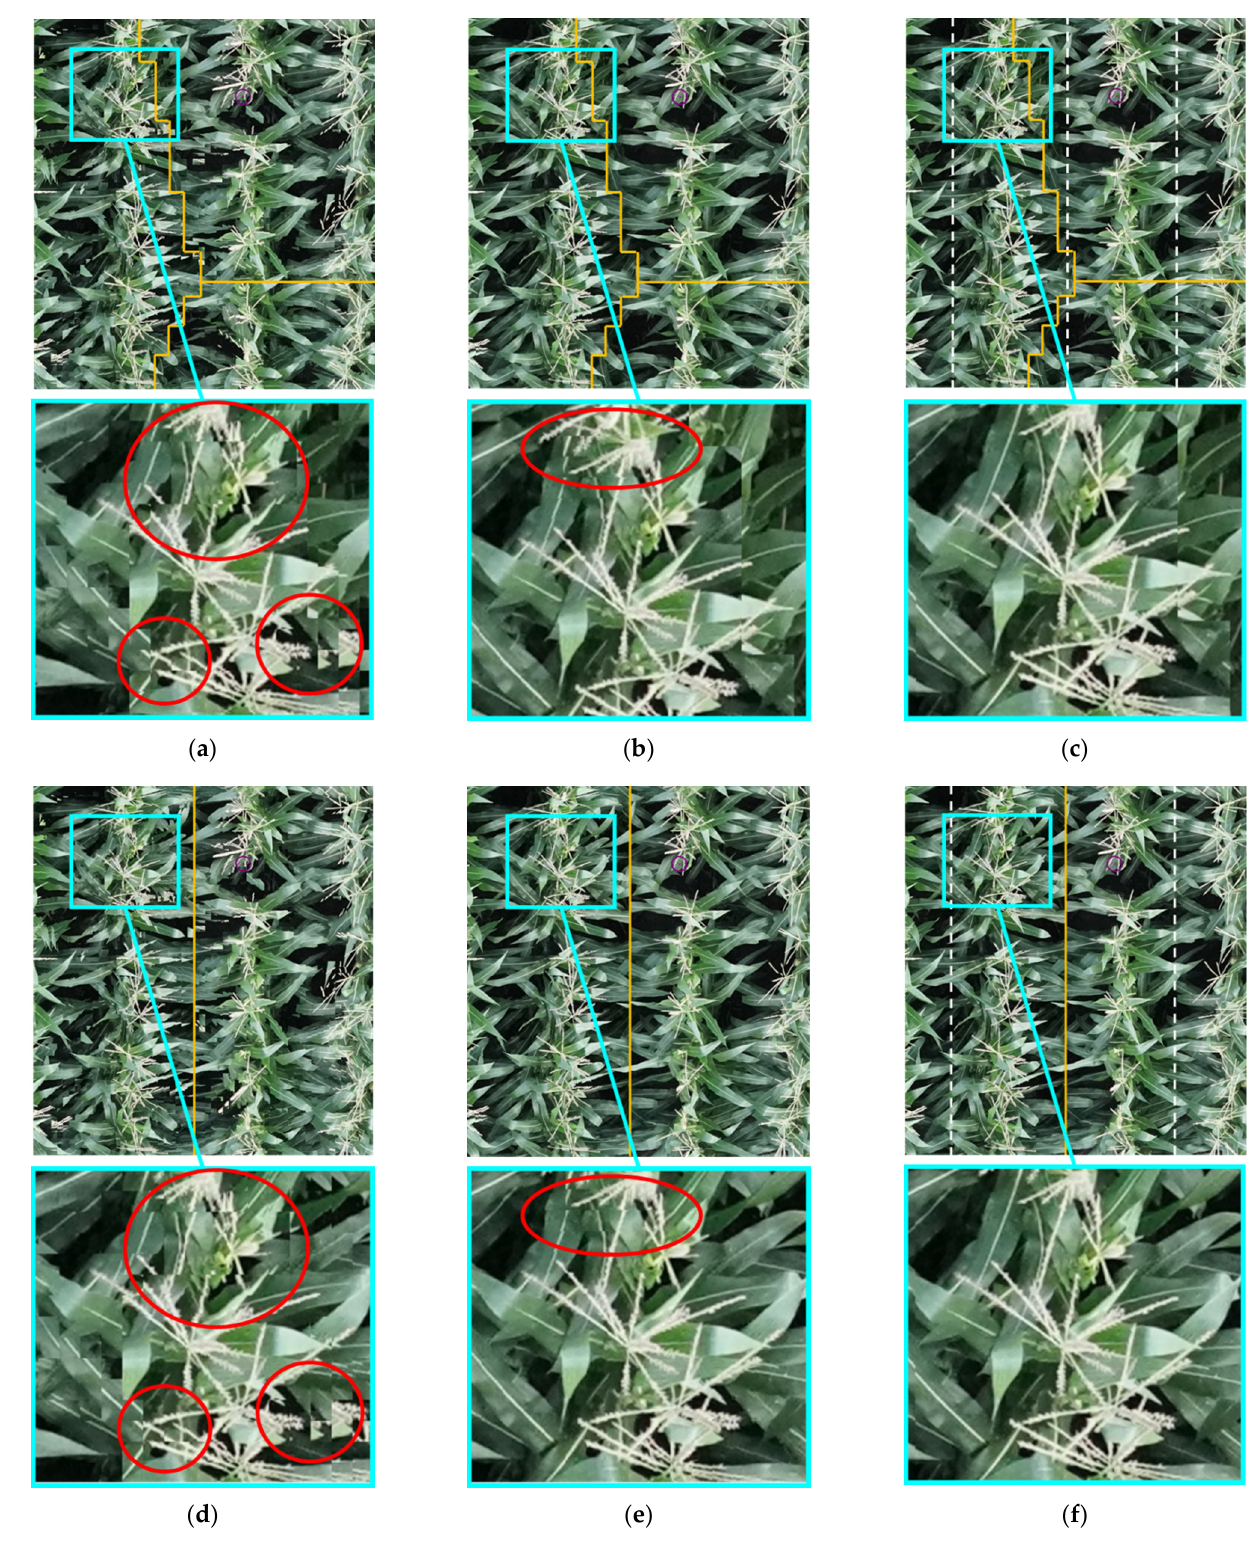
Figure 15. Portions of generated orthophotos using different DSM smoothing and seamline control strategies: ( a ) orthophoto i, ( b ) orthophoto ii, ( c ) orthophoto iii, ( d ) orthophoto iv, ( e ) orthophoto v, and ( f ) orthophoto vi. Yellow lines represent the seamlines, white dashed lines represent row segment boundaries, and red circles highlight areas with induced discontinuities by insufficient DSM smoothing.